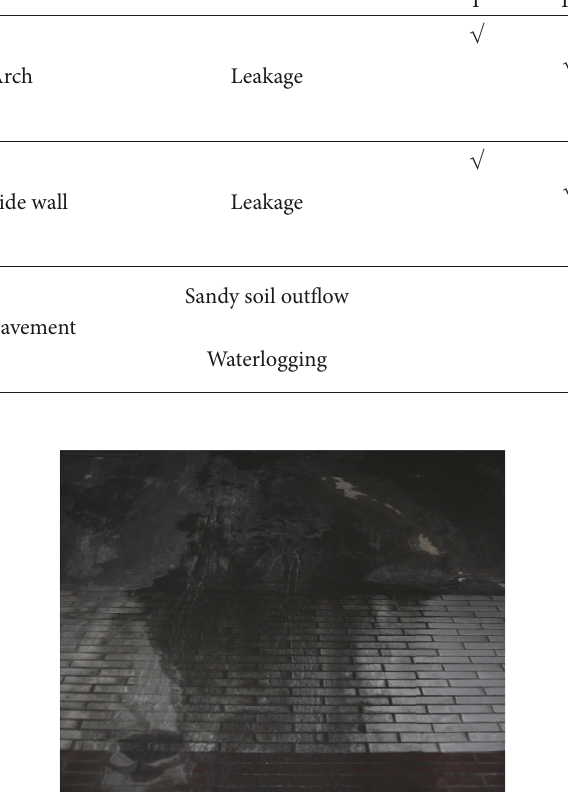
Figure 5: Leakage on middle wall of left tunnel.